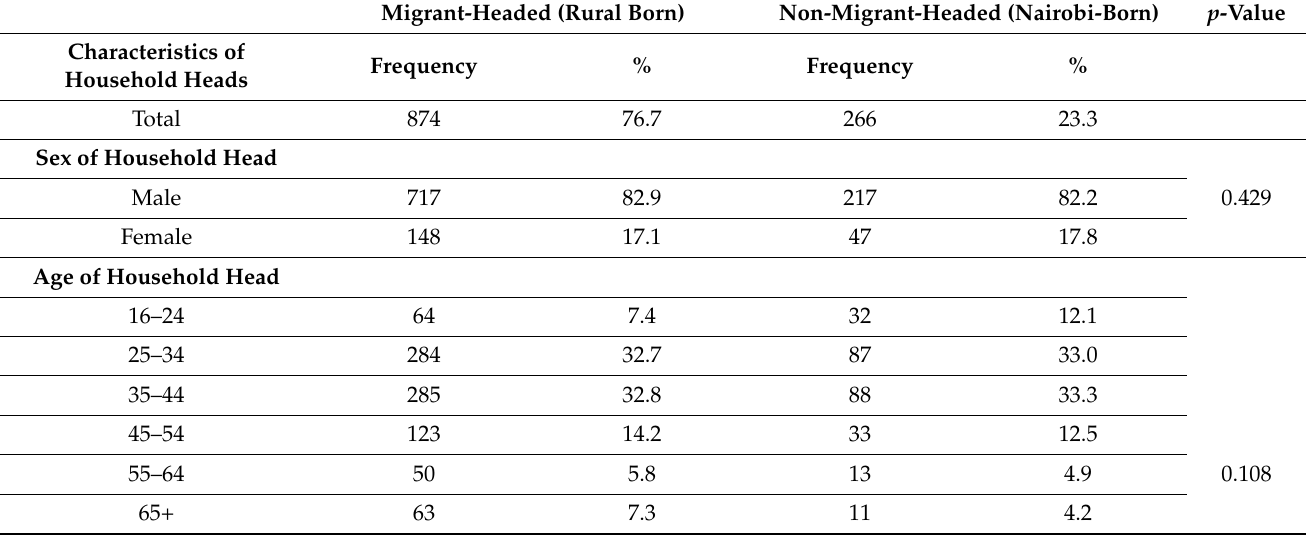
Table 1. Descriptive Characteristics of Migrant and Non-Migrant